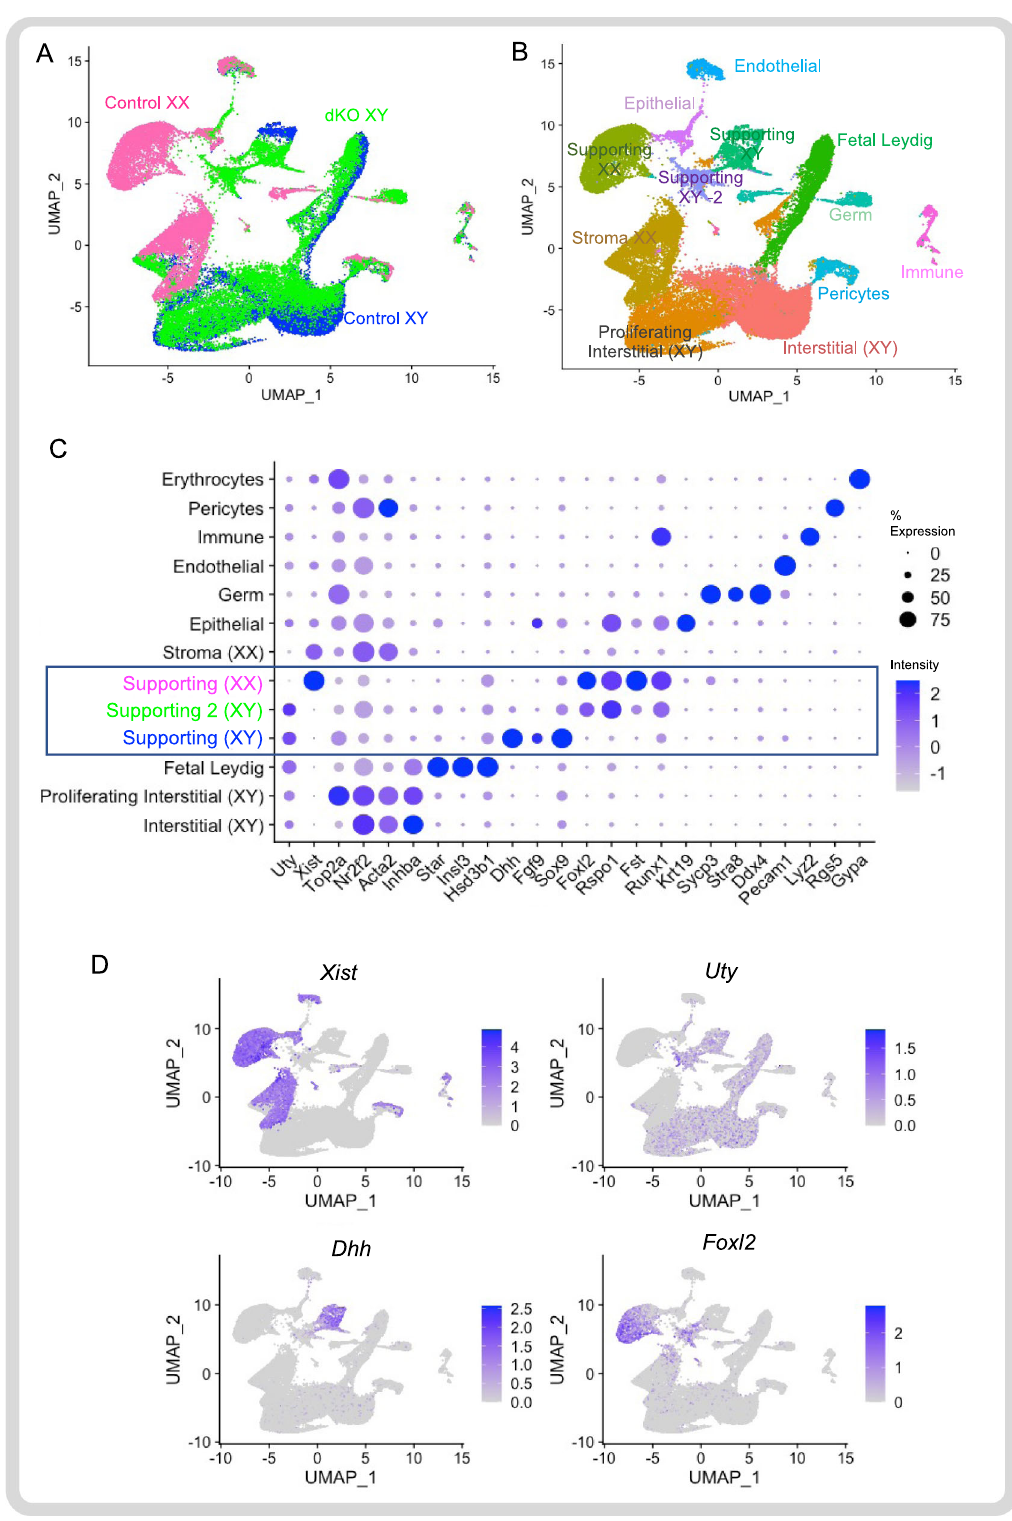
Fig. 3 Single cell mRNA sequencing analysis of control XX (ovary), control XY (testis) and dKO XY (ovotestis) at E15.5. A , B Genotype distribution and cell type clustering based on unbiased clustering of transcriptomic similarity. Thirteen cell clusters were identi fi ed. C Dot plots of the expression of genes used to identify each cluster. The rectangle highlights both XY and XX supporting cell populations. D Cell type distribution of the expression of Xist (X or female marker), Uty (Y or male cell marker), Sertoli cell marker ( Dhh ) and granulosa cell marker ( FoxL2 ). Source data are provided as a Source Data fi le. N = 2 biological independent samples per